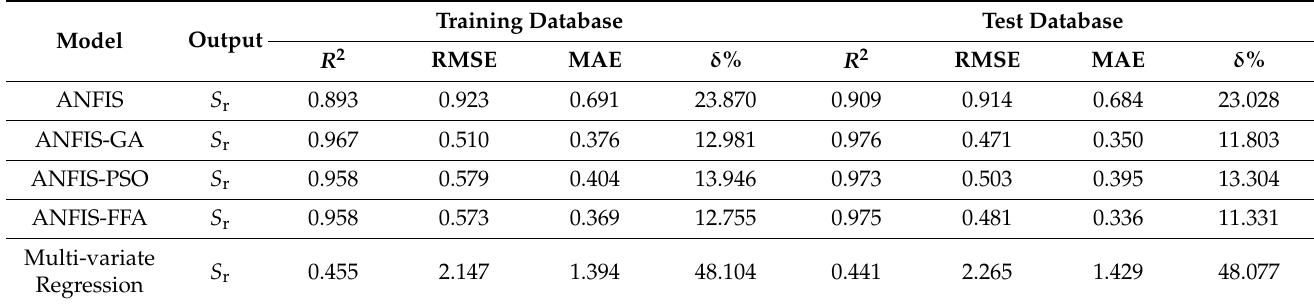
Table 3. Models’ performance evaluation for output S r .